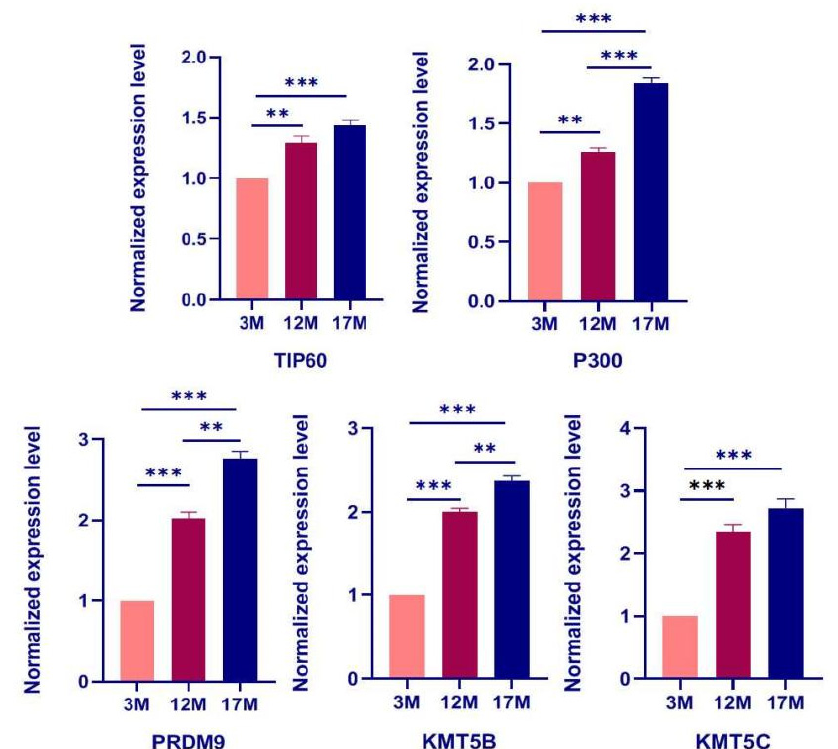
Figure 5. The expression of related regulatory enzymes was examined by quantitative real-time PCR